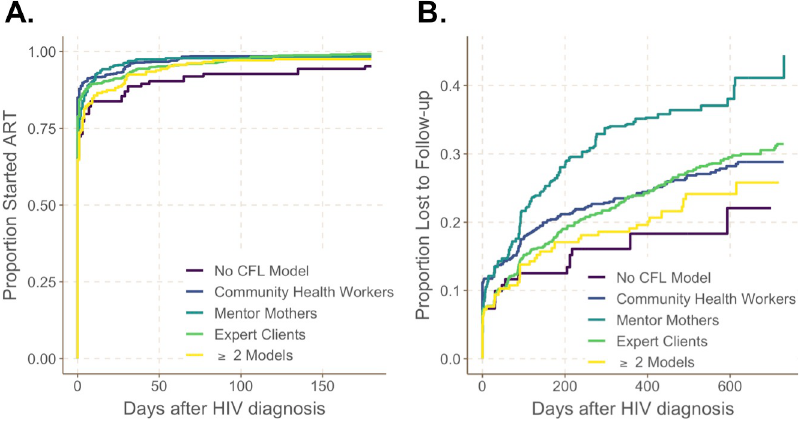
Fig 2. Maternal ART uptake and LTFU by CFL model ( N = 2,049). (A) Proportion of PBFW living with HIV who started ART. (B) Proportion of PBFW living with HIV lost to follow-up in the national PMTCT/ART program. ART, antiretroviral therapy; CFL, community-facility linkage; LTFU, loss to follow-up; PBFW, pregnant and breastfeeding women; PMTCT, prevention of mother-to-child transmission of HIV.